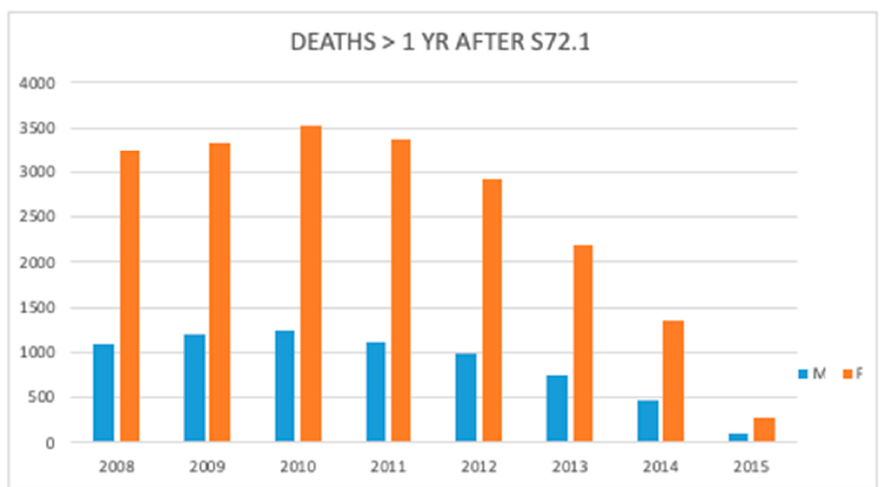
Figure 10. Number of deaths after one year following femoral neck (S72.0) and pertrochanteric fracture (S72.1) during the study period. J. Clin. Med. 2019 , 8 , x FOR PEER REVIEW